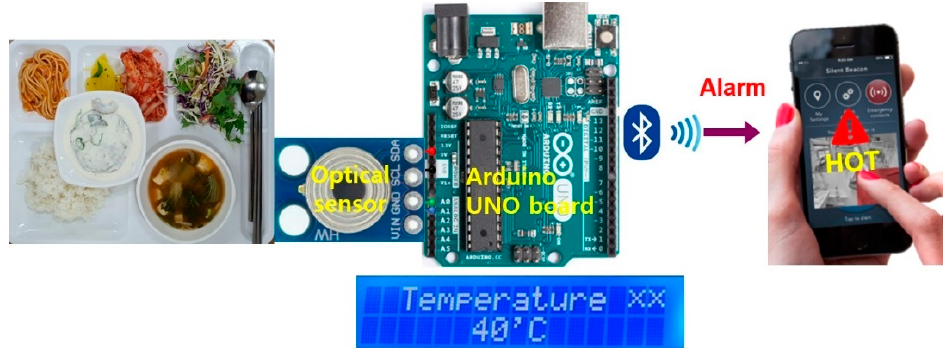
Figure 4. Conceptual architecture of a meal temperature-monitoring system.